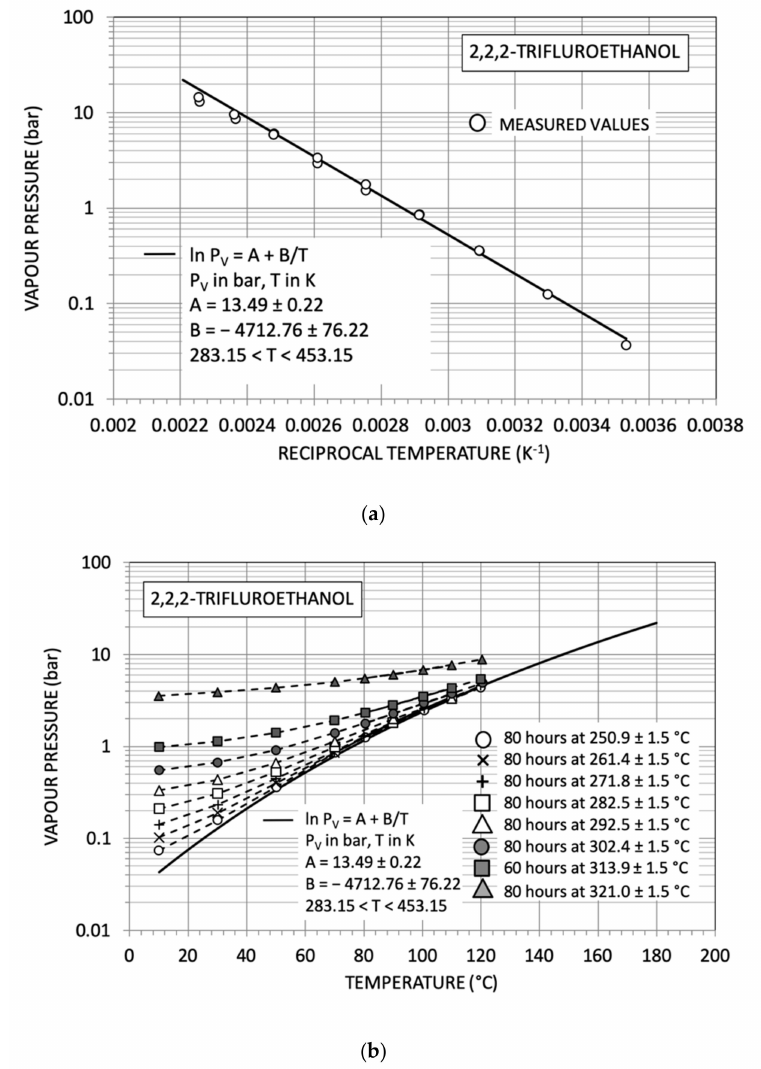
Figure 11. Thermal stability test for 2,2,2-trifluoroethanol: ( a ) reference vapour pressure (virgin fluid), ( b ) vapour pressure profile after di ff erent thermal stress